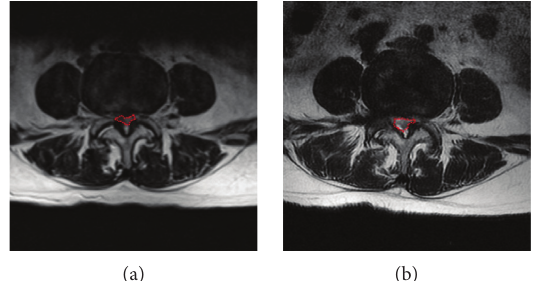
Figure 3: The cross-sectional area of the dural sac at the maximal compression level of a case with supine MRI scans. (a) Preoperative and (b) postoperative T2-weighted images plotted and measured on axial view using PACS. PACS � Picture Archiving and Communication